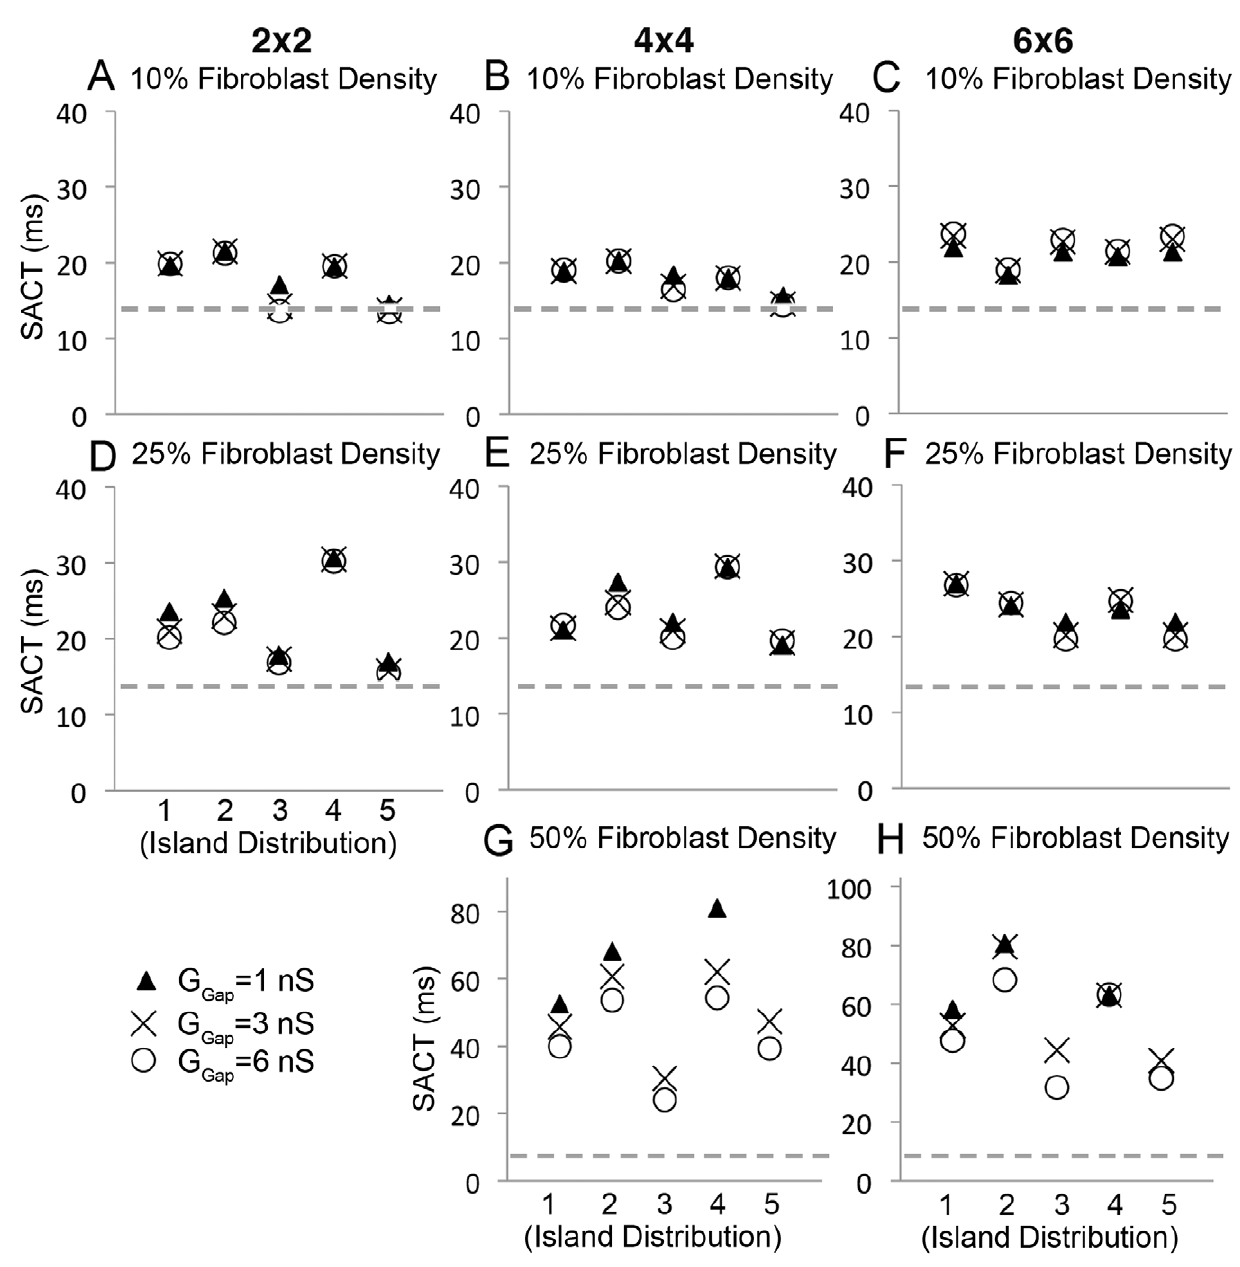
Figure 5. Modulation of sinoatrial node to atrium conduction time (SACT) by fibroblasts is shown. Panels show effects of different fibroblast spatial distributions, island sizes, fibroblast density and fibroblast-myocyte coupling values (G gap ). In each panel, G gap is 1 nS (triangle), 3 nS (X) or 6 nS (circle). A–C) 10% coverage - neither island distribution nor coupling affect SACT. D–F) 25% coverage - island distribution does affect SACT (see text). G–H) 50% coverage - both island distribution and coupling affect SACT. The dashed gray line denotes the value of SACT (13.8 ms) without fibroblasts.